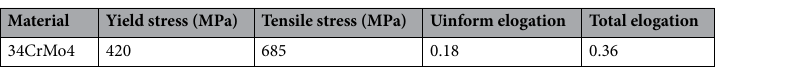
Table 2. Mechanical properties of 34CrMo4.